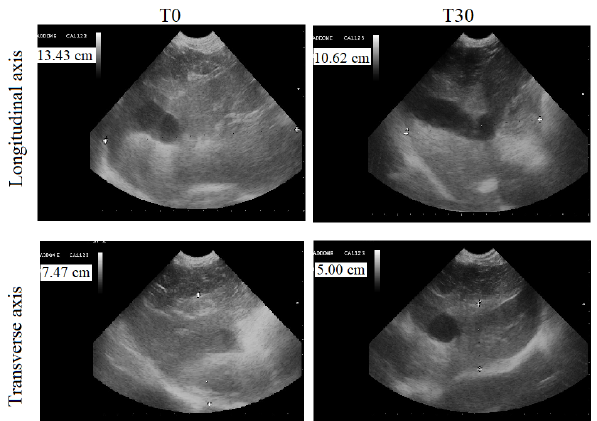
Figure 4. Liver ultrasound performed by a 5 MhZ probe, at T0 (before the beginning of treatment) and T3 (30 days after the administration of Epacare pet + pasta ® ) of a representative dog from the B T group. Figure 2. Mean ± standard deviation (SD) of serum liver enzymes used as inclusion criteria (aspar- tate aminotransferase—AST, alanine aminotransferase—ALT; alkaline phosphatase—ALP) rec- orded for the different data points ( T0; T1; T2; T3) of the experimental protocol, in all groups (Ac = control not treated; A T = control treated; B C = hill not treated and B T = hill treated).